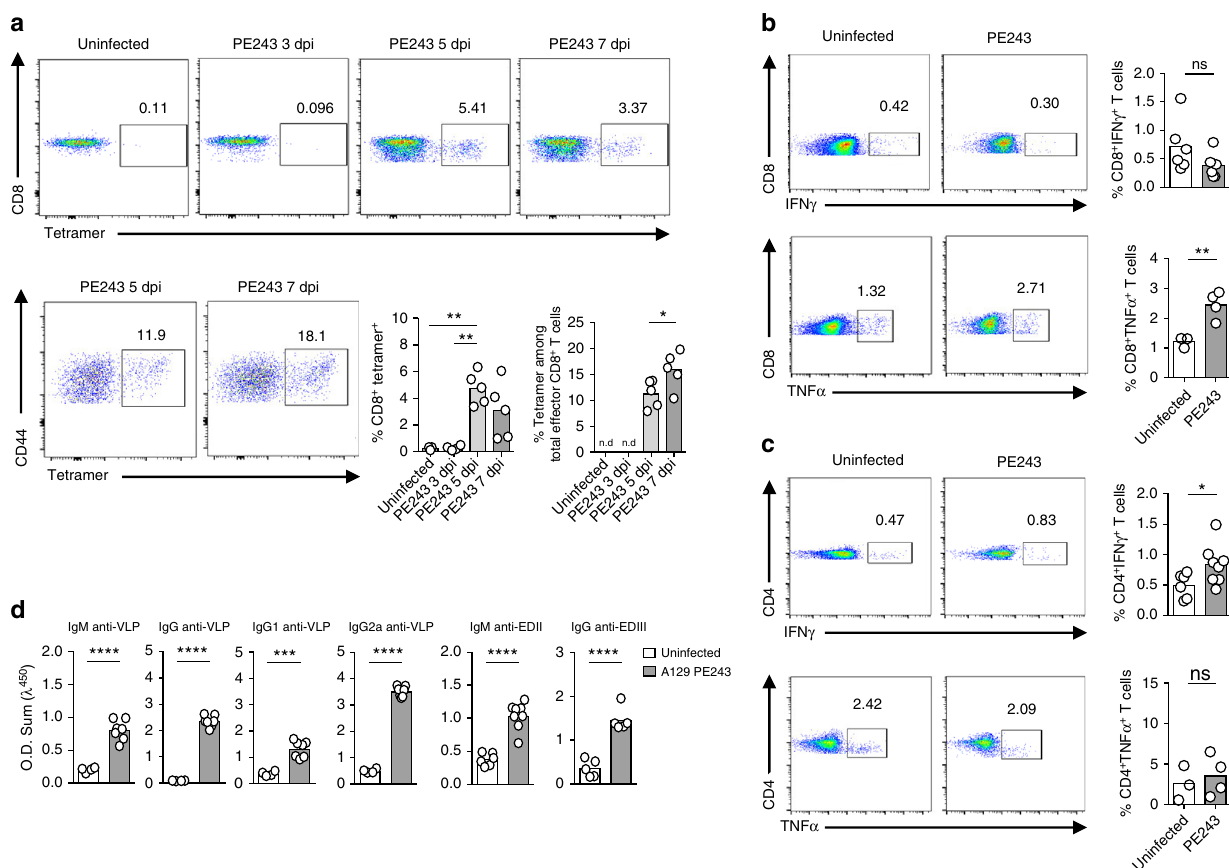
Fig. 2 Four-week-old A129 mice elicit speci fi c immune response against ZIKV PE243. Four-week-old A129 mice were inoculated intravenously with 2 × 10 5 PFU of ZIKV strain PE243. Uninfected mice were used as control. a Representative dot plot and frequency of protein E ZIKV tetramer positive cells among CD8 + T cells or total CD8 + CD62L − CD44 + cells (effector). Data were obtained from ZIKV PE243-infected A129 mice at days 3 ( n = 4), 5 ( n = 5), and 7 ( n = 5) postinfection and compared to uninfected mice ( n = 3). For intracellular cytokines analyzes by means of fl ow cytometry, splenocytes were obtained from uninfected A129 mice ( n = 3 – 6) or ZIKV PE243-infected A129 mice ( n = 4 – 8) at day 7 postinfection, restimulated in vitro using UV-inactivated ZIKV during 72 h in the presence of brefeldin A added in the last 8 h. b Representative dot plot and frequency of IFN γ and TNF α among CD8 + T cells. c Representative dot plot and frequency of IFN γ and TNF α among CD4 + T cells. d Serum IgM and IgG anti-ZIKV VLP or anti-ZIKV-EDIII as well as serum IgG1 and IgG2a anti-ZIKV-VLPs in ZIKV PE243-infected A129 mice ( n = 8), compared to uninfected A129 mice ( n = 4). Results are shown as mean. Data are representative of two independent experiments in d , data are presented as a pool of two independent experiments in b and c , experiments were performed once in a . Data were analyzed by Student ’ s t test. * p ≤ 0.05; ** p ≤ 0.01; *** p ≤ 0.001; **** p ≤ 0.0001; ns not signi fi